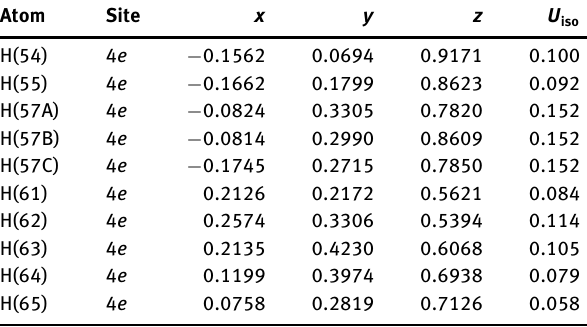
Table 3: Fractional coordinates and atomic displacement parameters (Å 2